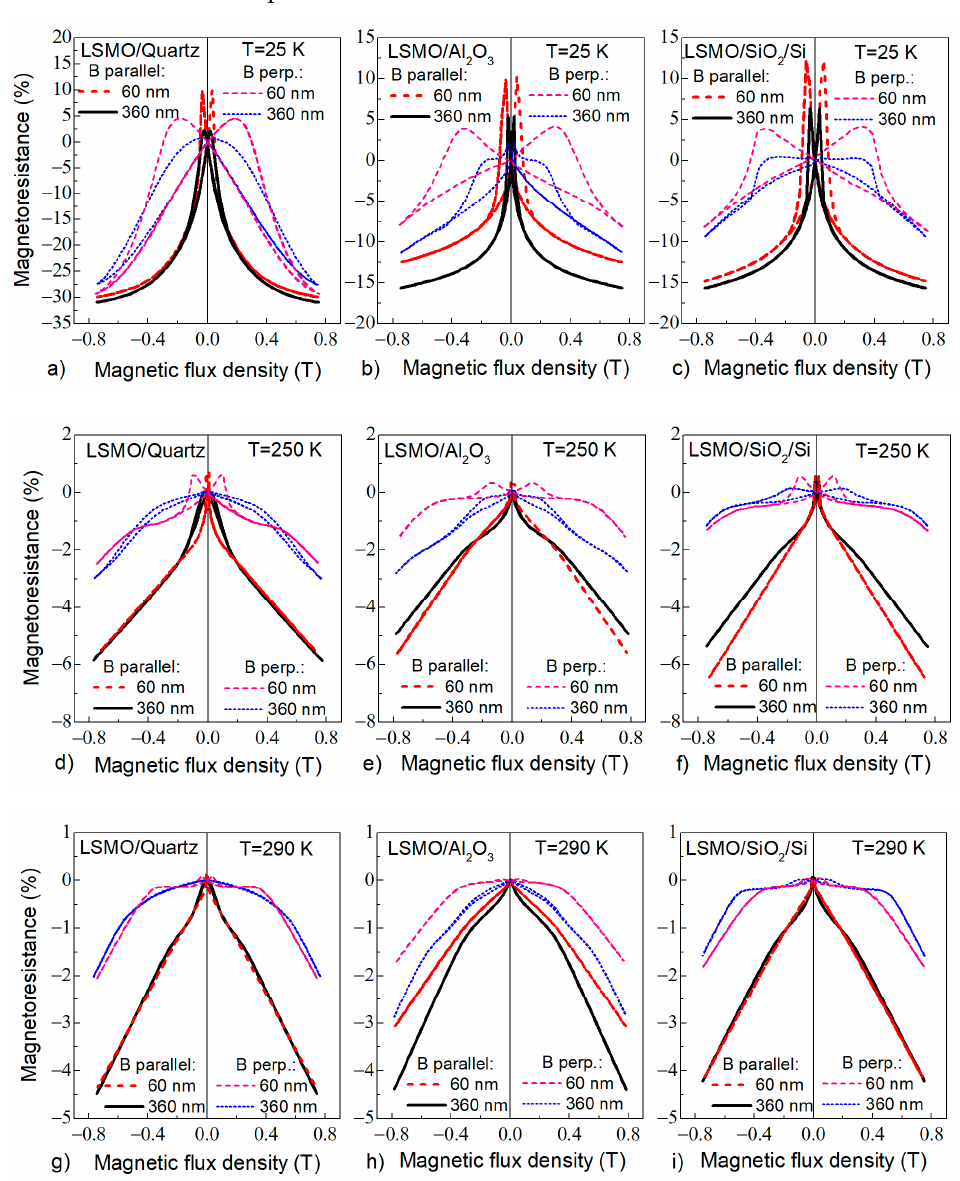
Figure 9. Low-field magnetoresistance dependences on magnetic flux density for different thickness films (60 nm and 360 nm) grown on different substrates and measured at various ambient temperatures: 25 K, 250 K, 290 K.